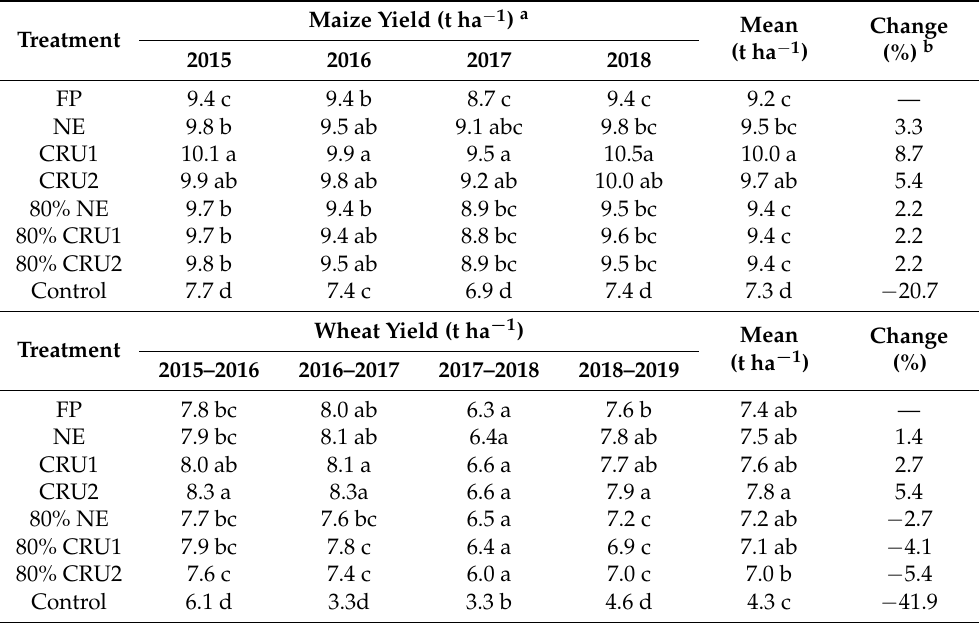
Table 1. Yields of maize (top) and wheat (bottom) in different fertilizer treatments in four growing seasons of a wheat–maize rotation from June 2015 to June 2019 in north-central China.